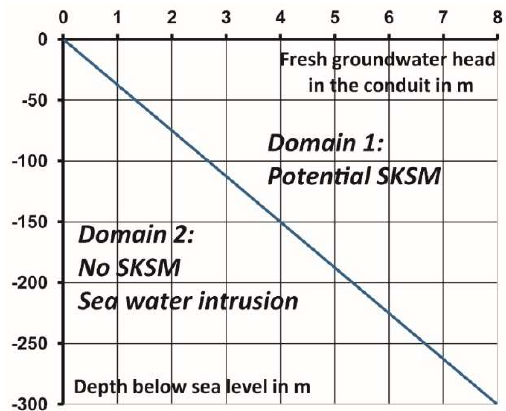
Figure 5. Diagram showing the depth below sea level at which a KSMS may discharge, depending on the fresh water head in the conduit discharging at the